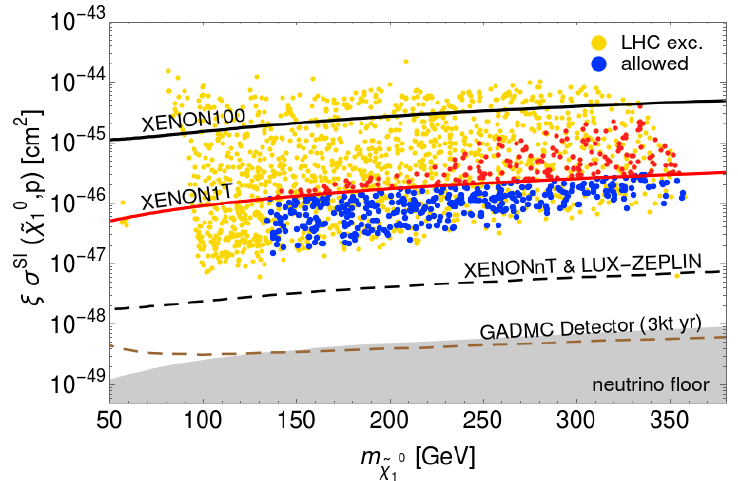
(cid:31) 0 ; p ) vs. e 1